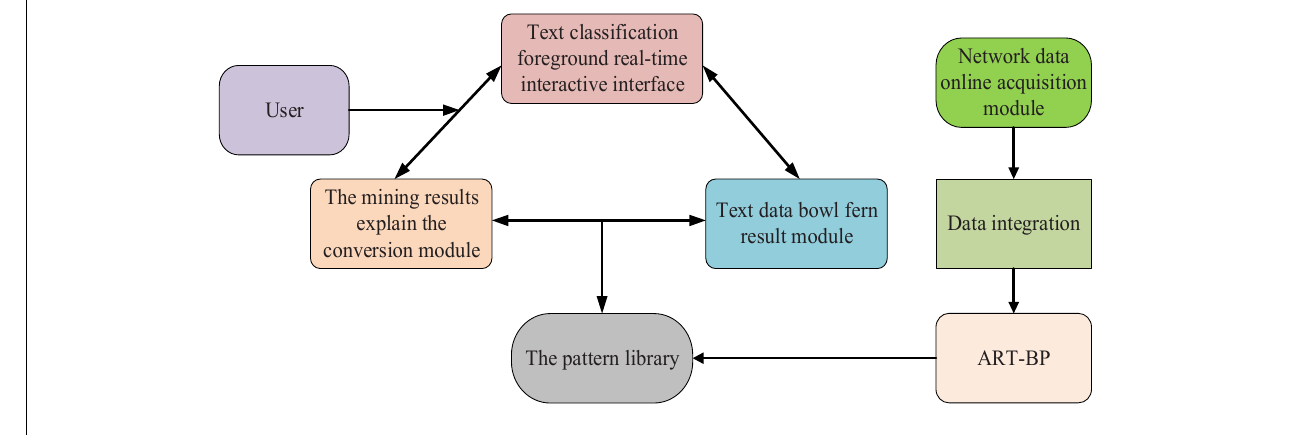
FIGURE 4 | Structure of text classification system based on ART-BP model.